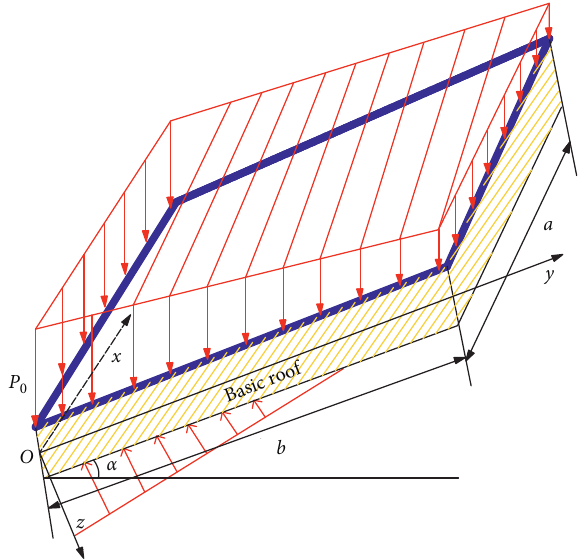
Figure 1: Mechanical model of the main roof in SDCS.